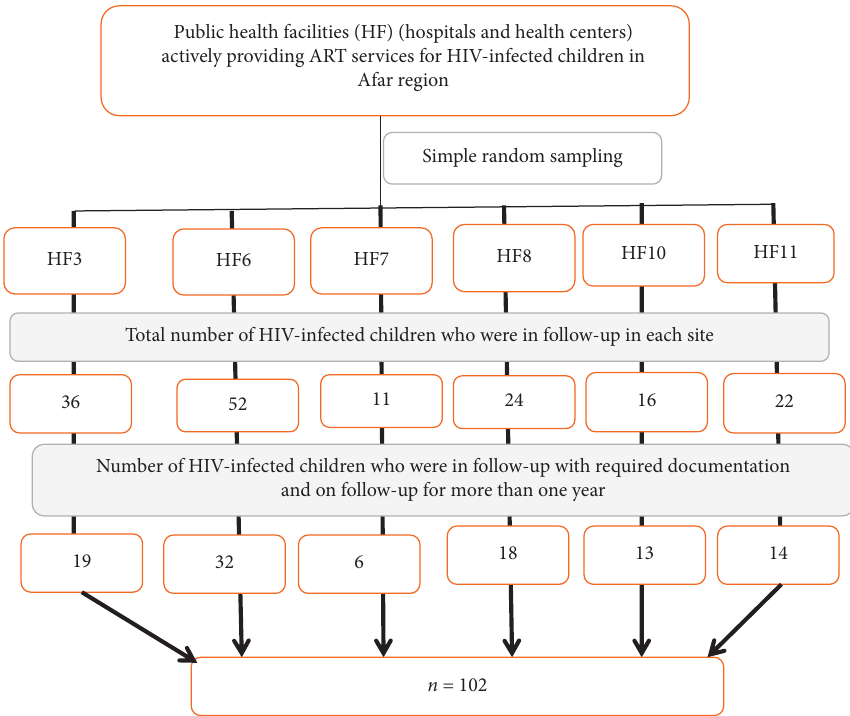
Figure 1: Flow diagram (sampling procedure) for selecting study